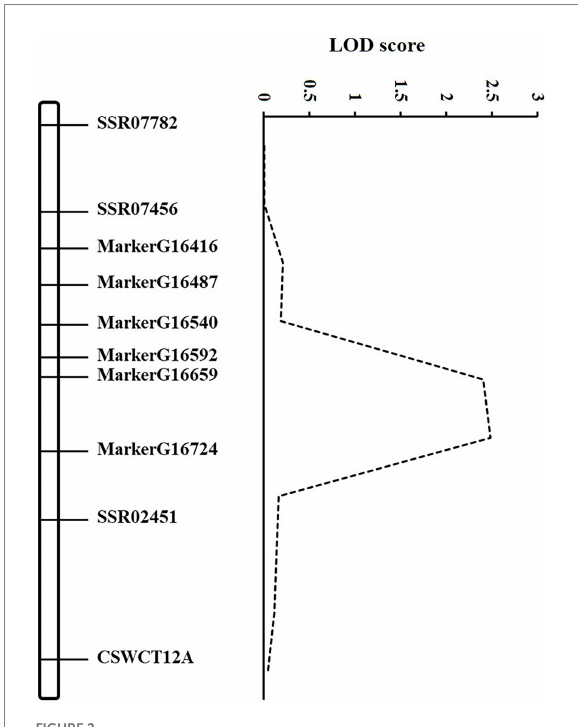
FIGURE 2 Genetic map of gsb3.1 on Chromosome 3. Mapping of the gsb3.1 QTL associated with GSB resistance at the seedling stage of cucumber. The dashed line curve indicates the LOD score relative to the physical position of genetic